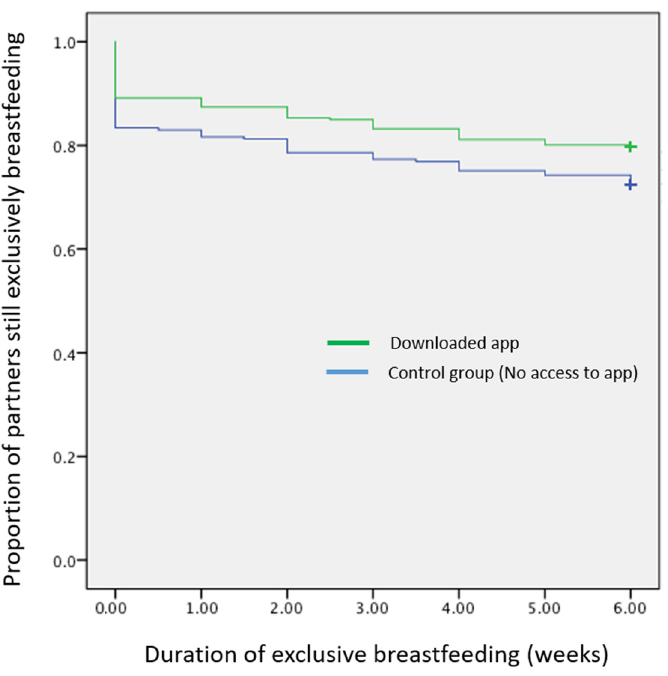
Figure 1. Prevalence of exclusive breastfeeding in first 6 weeks by use of Milk Man app.